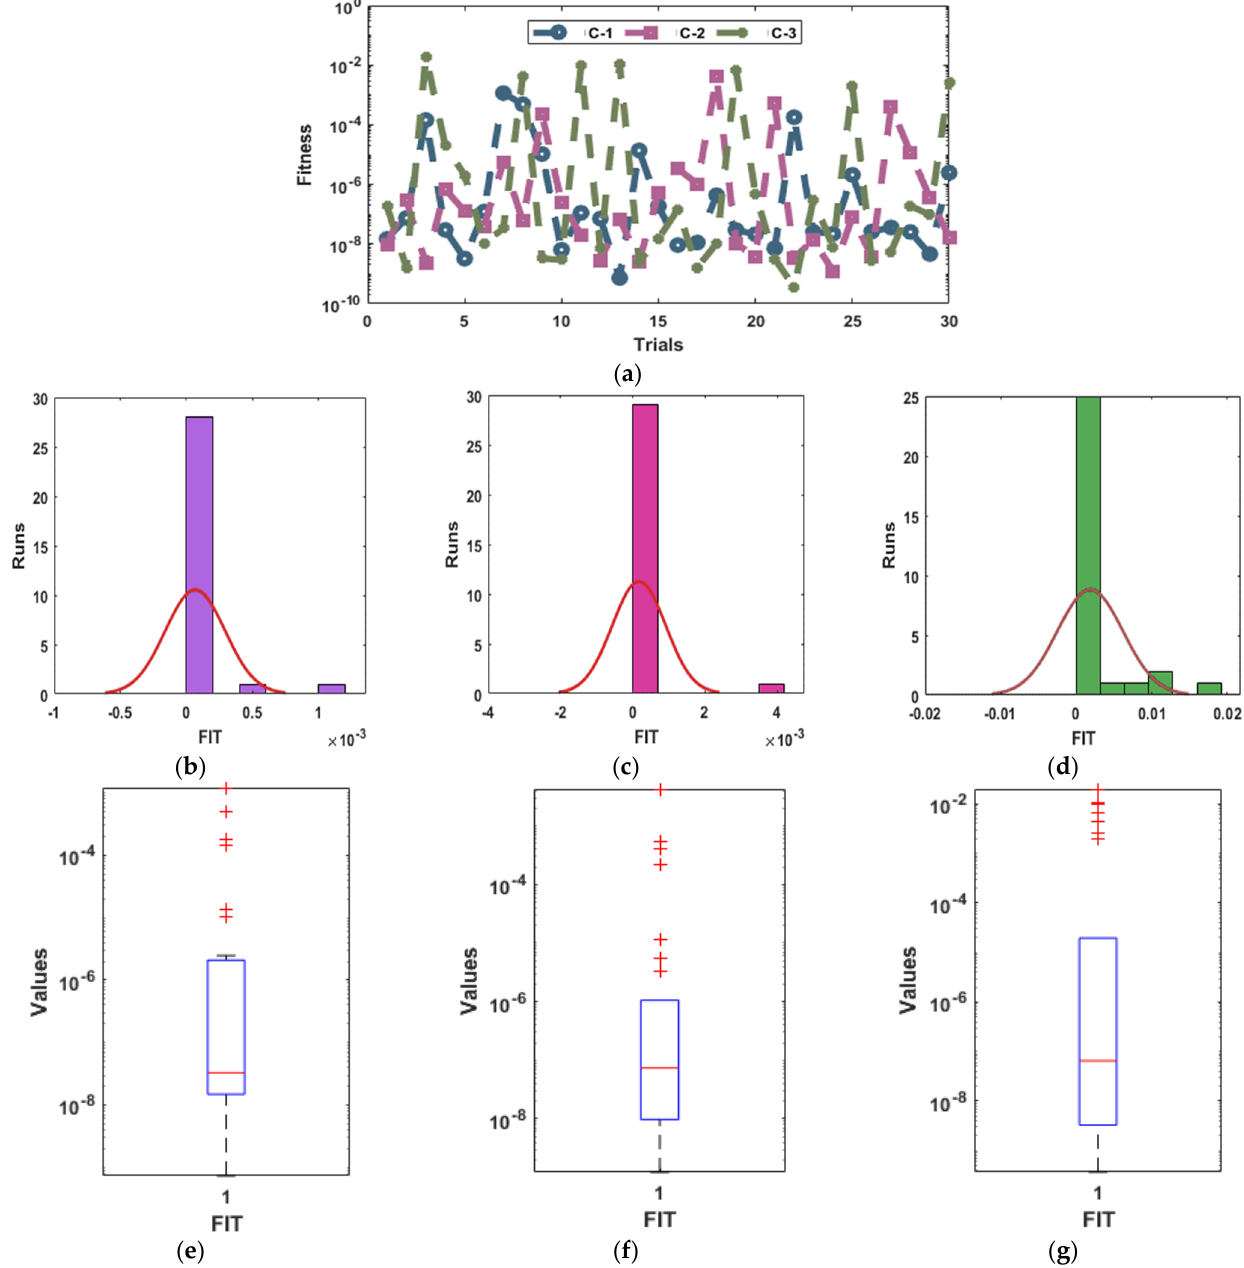
Figure 4. Performances through the statistical measures for the Fitness values based on the NSPM-SK. ( a ) Performances of the Fitness for case 1 to 3. ( b ) Hist of C-1. ( c ) Hist of C-2. ( d ) Hist of C-3. ( e ) BPs of C-1. ( f ) BPs of C-2. ( g ) BPs of C-3.